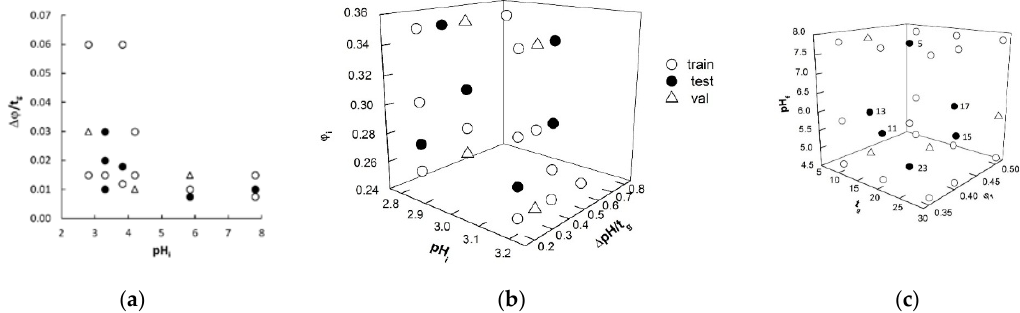
Figure 1. Gradients used in artificial neural network (ANN) training, validation, and test data projected in the space of the variables adopted as network inputs for datasets A ( a ), B ( b ), and C ( c ). Test samples of dataset C are labeled according to Reference [15].